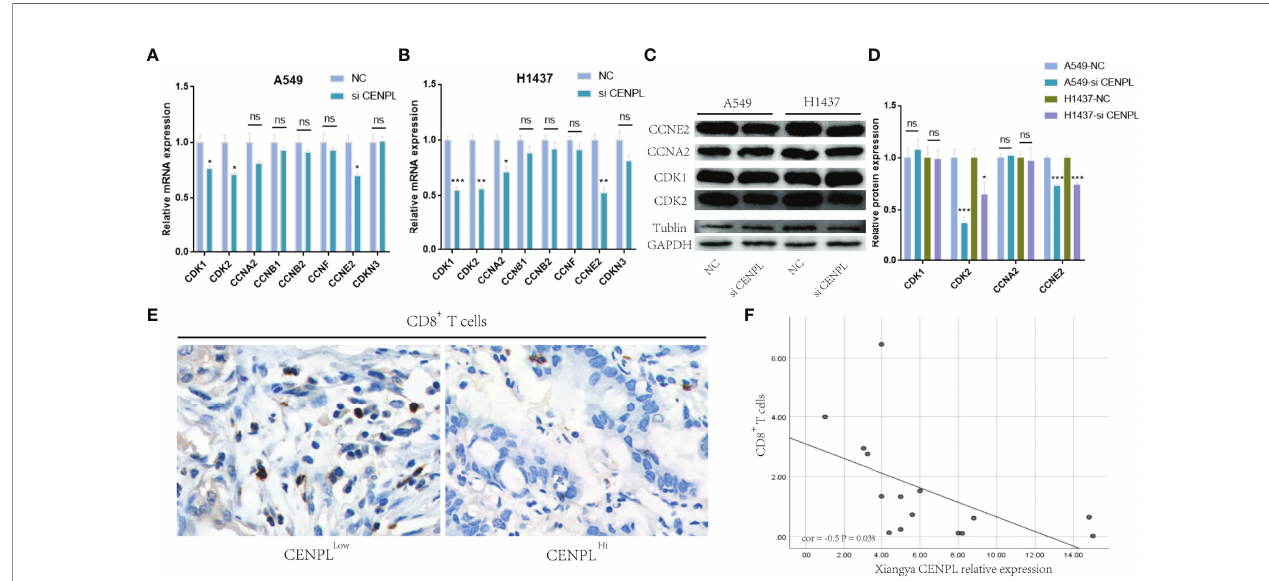
FIGURE 10 | Knockdown of CENPL signi fi cantly suppressed the expression of CDK2 and CCNE2. (A, B) Knockdown of CENPL suppressed the mRNA expression of CDK1, CDK2, CCNA2, and CCNE2 in A549 and H1437 cells. (C, D) Knockdown of CENPL signi fi cantly suppressed the protein expression of CDK2 and CCNE2 in A549 and H1437 cells. (E, F) CENPL is negatively associated with CD8 + T-cell in fi ltration. (*P < 0.05, **P < 0.01, ***P < 0.001, ns, no signi fi cance).